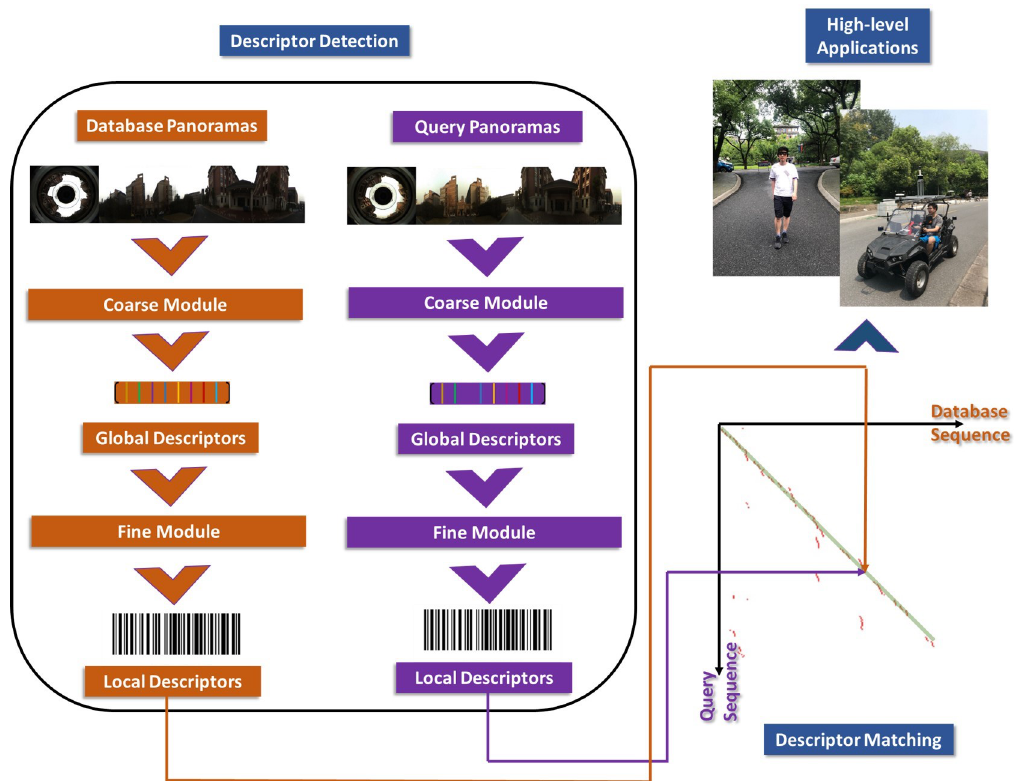
Figure 2. Panoramic descriptor detection, descriptor matching procedures in VPR, and their high-level navigation assistance applications for VIP or autonomously driving vehicles. (The curve at the right bottom represents the descriptor matching relationship between query images and the corresponding best matched database images. The red points refer the matching instance points and the green line is on behalf of the ground